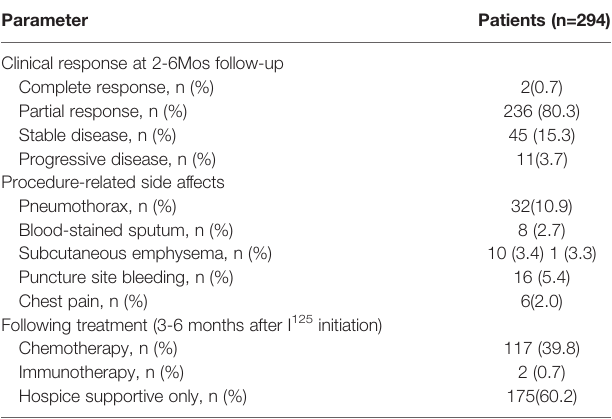
TABLE 4 | Clinical outcomes and therapeutic-related side effects of SNCP- 125 I brachytherapy treated patients. Parameter Patients